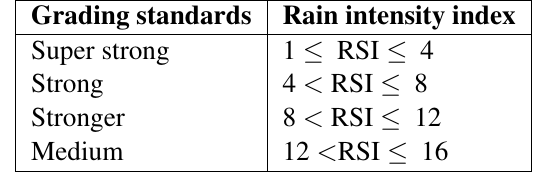
Table 3 Grading Standard of Comprehensive Rainfall Intensity